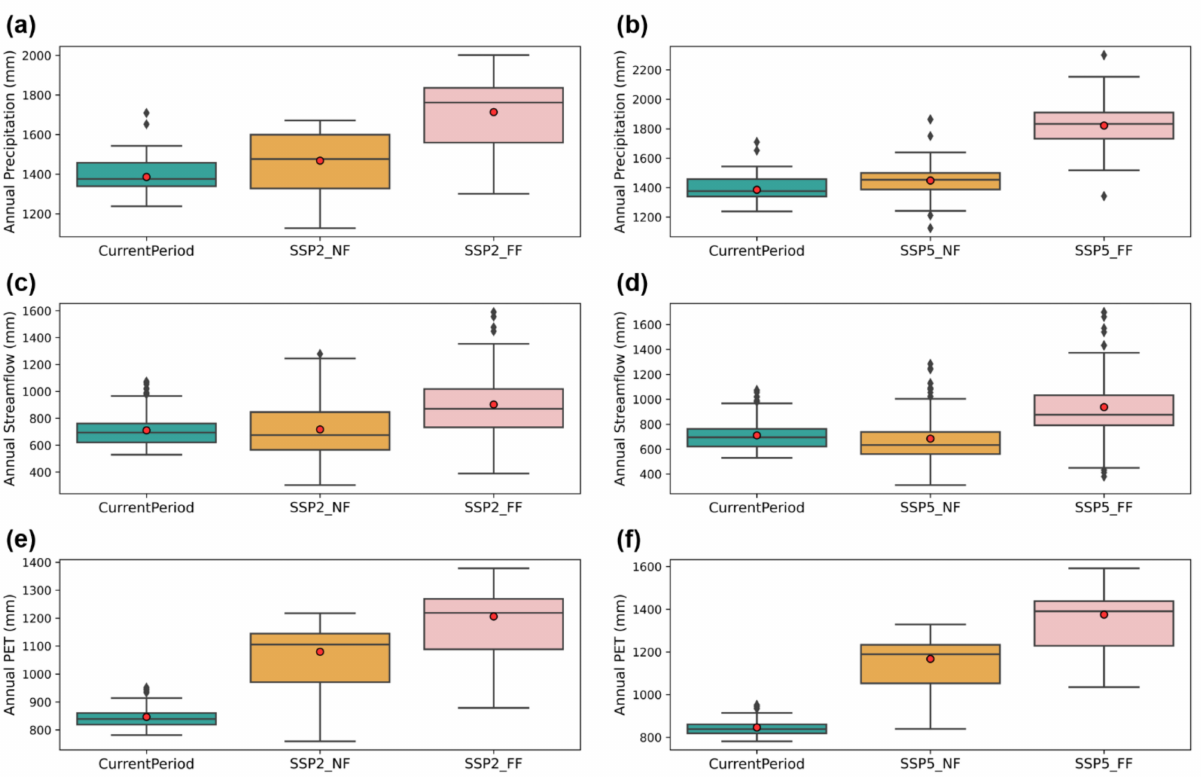
Figure 6. Boxplot of annual precipitation, streamflow, and potential evapotranspiration (PET) for the current period, NF, and FF for two climate change scenarios: ( a ) annual precipitation under SSP2 scenario; ( b ) annual precipitation under SSP5 scenario; ( c ) annual streamflow under SSP2 scenario; ( d ) annual streamflow under SSP5 scenario; ( e ) annual potential evapotranspiration under SSP2 scenario; ( f ) annual potential evapotranspiration under SSP5